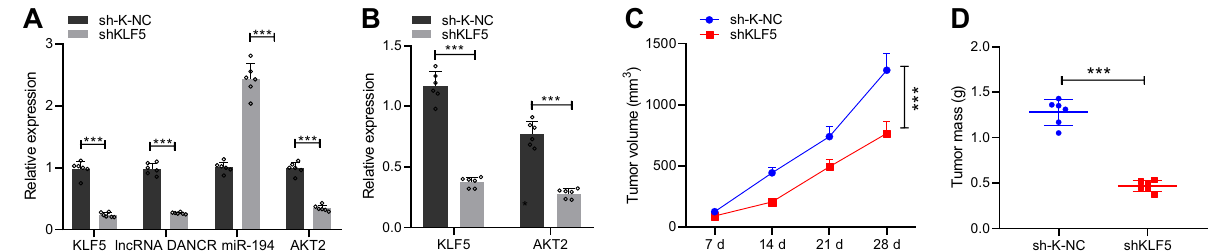
Fig. 7 KLF5 knockdown inhibits tumor growth in vivo by regulating the DANCR/miR-194/AKT2 axis. A qRT-PCR to determine the expression of KLF5, DANCR, miR-194, and AKT2 in nude mouse tumor tissue; B western blot assay to measure the protein expression of KLF5 and AKT2 in nude mouse tumor tissue; C quantitative analysis of tumor volume growth in nude mice; D quantitative analysis of tumor weight in nude mice; * p < 0.05, ** p < 0.00, *** p < 0.0001. The measurement data are summarized by mean ± standard deviation. Data in A , B , D